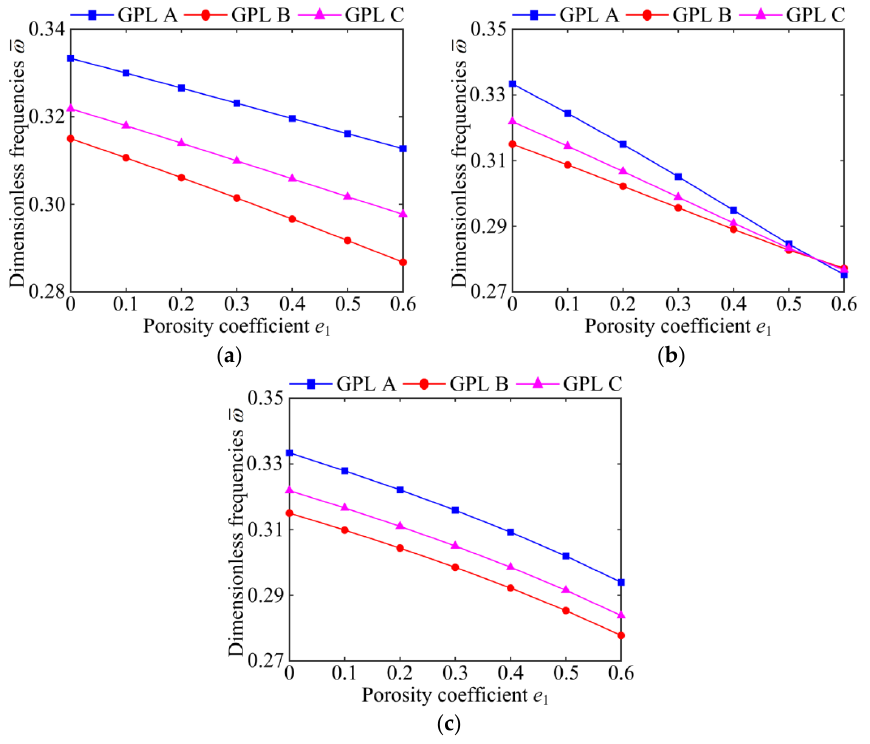
Figure 5. The influences of porosity coefficient on dimensionless fundamental frequencies of the GPLRP, two-cylindrical-panel system (SSSS). ( a ) Porosity-I; ( b ) Porosity-II; ( c ) Porosity-III.